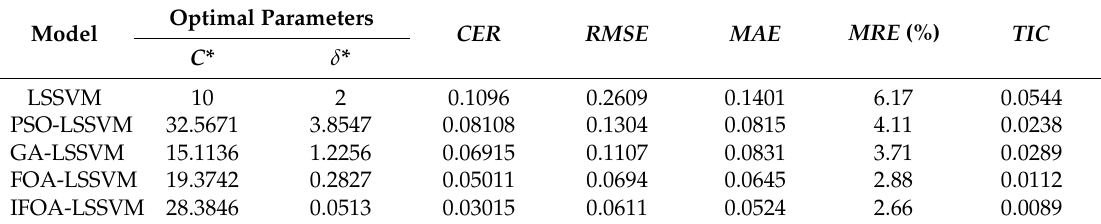
Table 2. Comparison of LSSVM, PSO-LSSVM, GA-LSSVM, FOA-LSSVM and IFOA-LSSVM models. Model